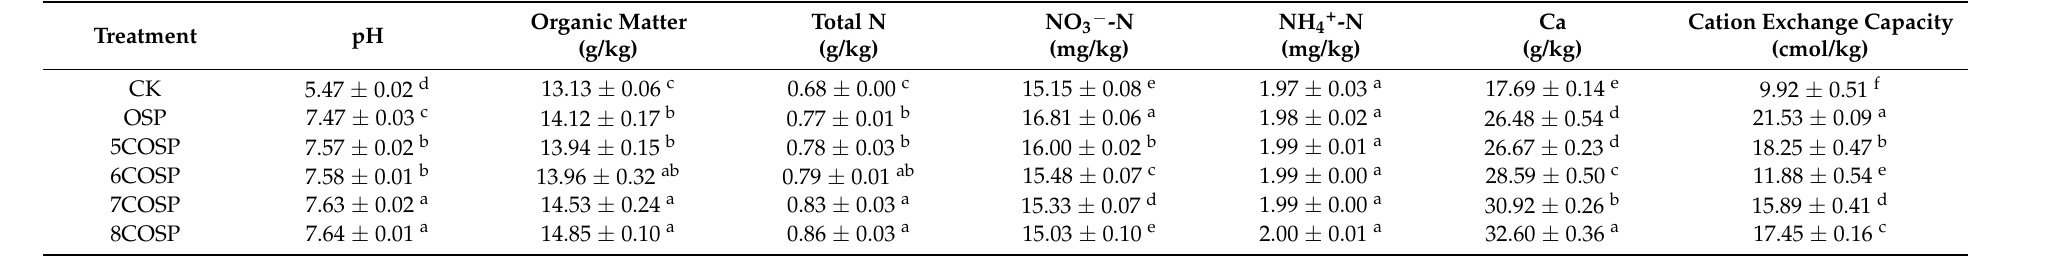
Table 3. Physicochemical properties of soils cultured with the